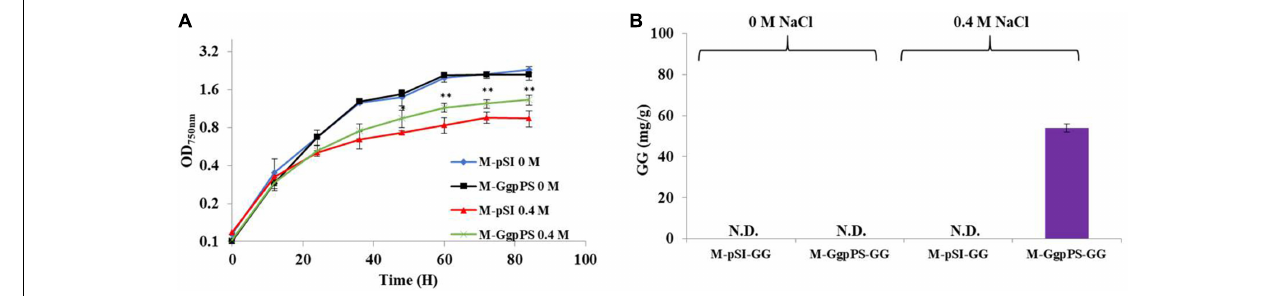
FIGURE 2 | Growth curves and GG synthesis of strains M-pSI and M-GgpPS. (A) Growth curves of strains M-pSI and M-GgpPS under 0 M and 0.4 M NaCl; (B) GG synthesis of strain M-pSI and M-GgpPS under 0 M and 0.4 M NaCl. N.D., not